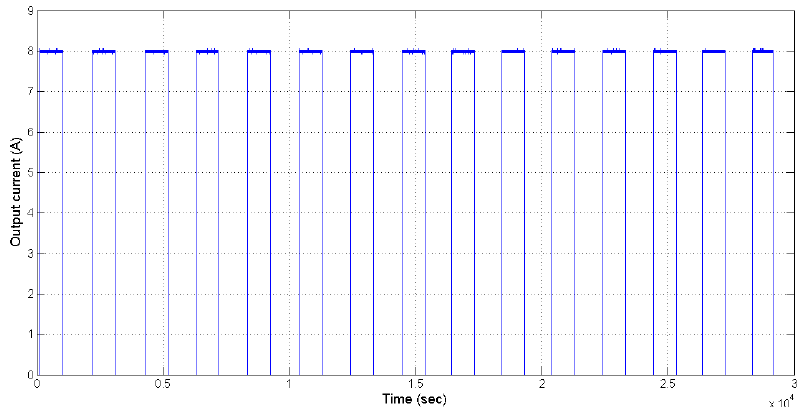
Figure 4. The pulsating current with constant amplitude (8 A) drawn by the electronic load.